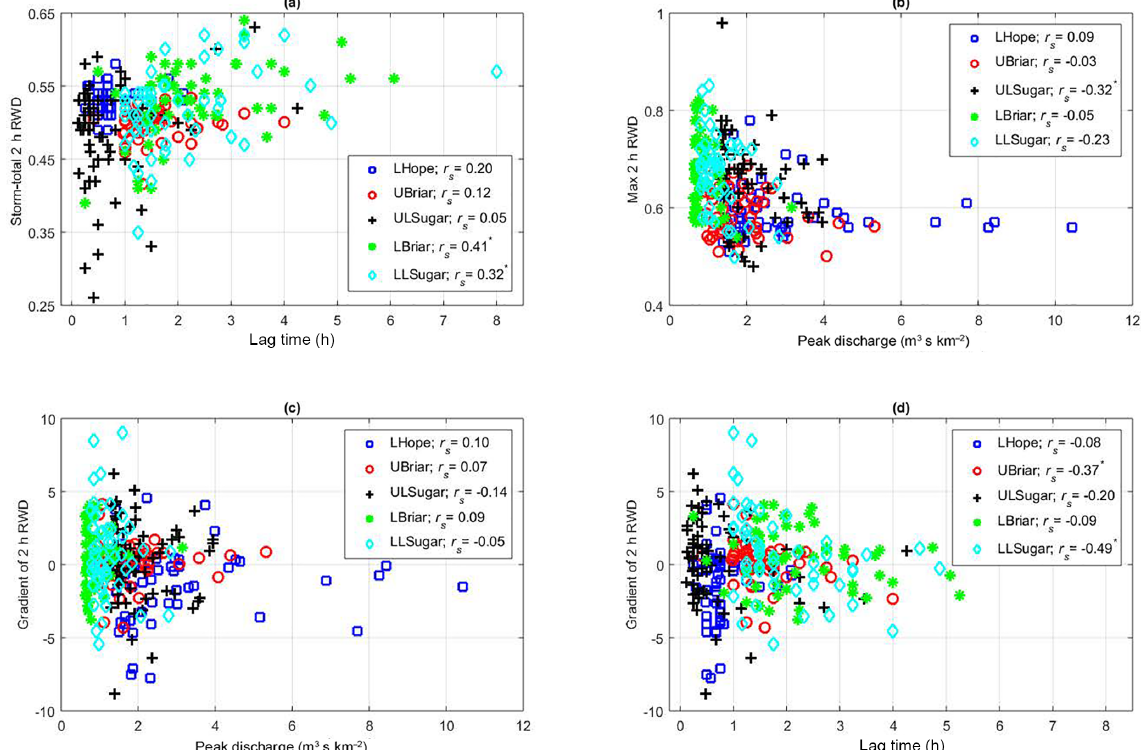
Figure 7. Scatter plots for storm-total RWD (2h window) versus lag time (a) , maximum RWD (2h window) versus peak flow (b) , gradient in RWD (2h window) versus peak flow (c) and gradient in RWD (2h window) versus lag time (d)